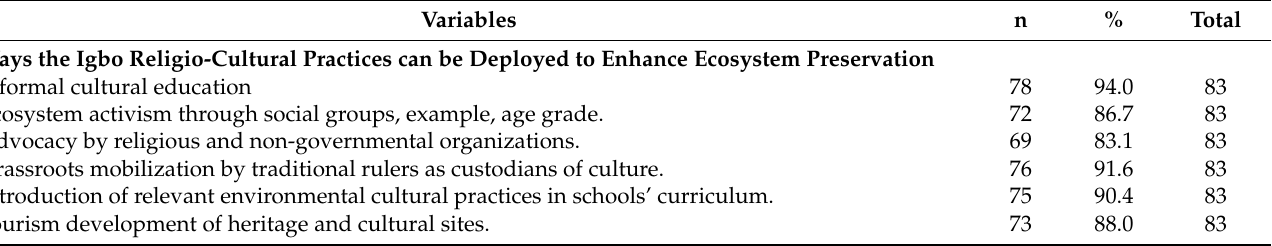
Table 3. Ways the Igbo Religio-Cultural Practices can be Deployed to Enhance Ecosystem Preservation.